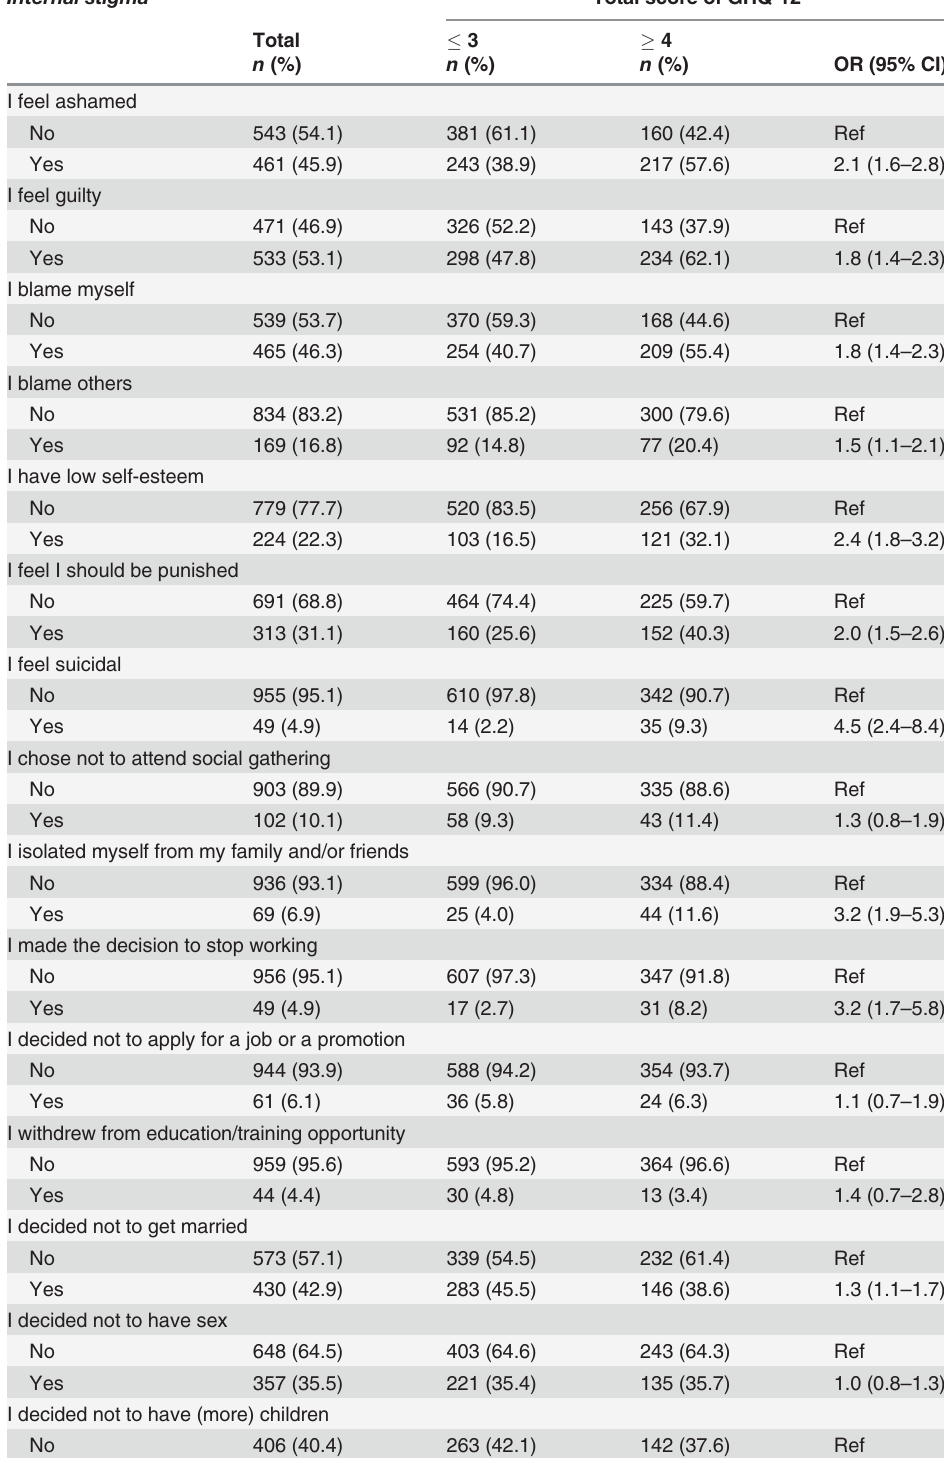
Table 3. Comparisons of internal stigma experienced in the past 12 months among PLHIV with lower and higher levels of mental